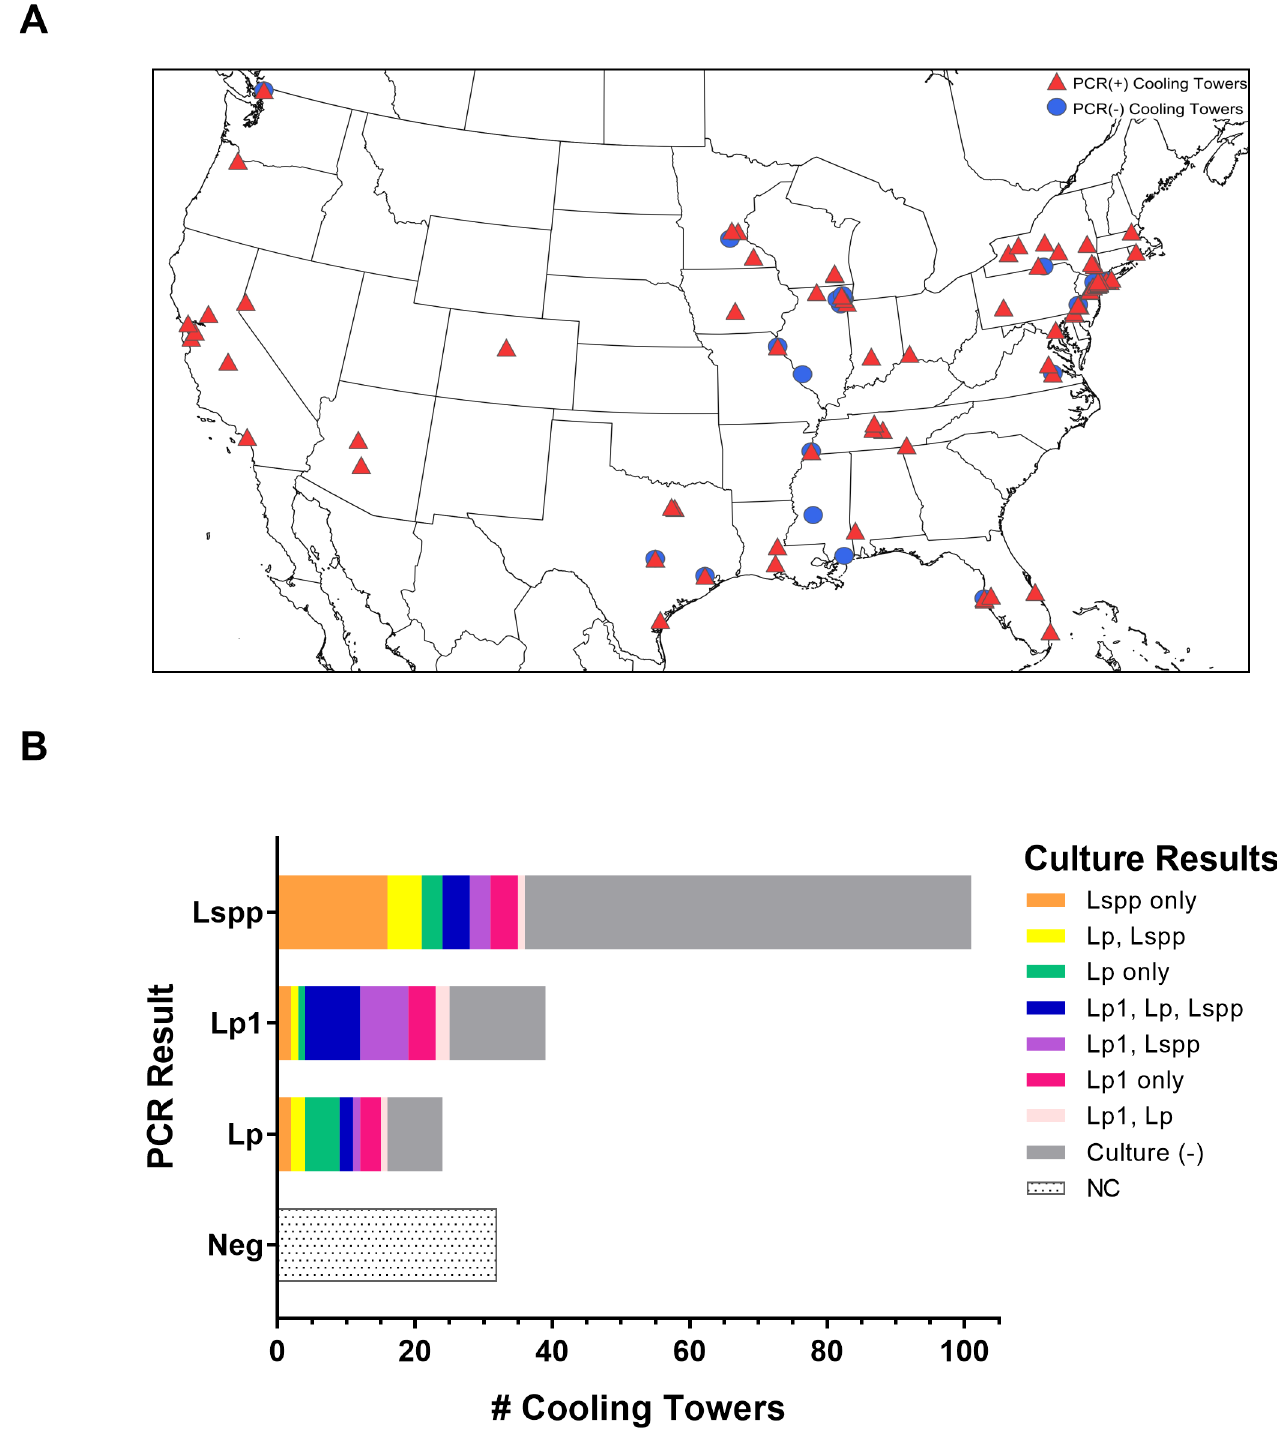
Fig 1. Cooling tower locations and PCR and culture results overview. The CT samplesin this study were from geographiclocationsacross the US (A). The approximate longitudeand latitudeof the city for each CT location is plotted on the map which was generatedwith SimpleMappr (www.simplemappr.net). CTs that were positive for Legionella DNA by PCR are representedby red triangles[PCR (+)] and those negativeby PCR are shown as blue circles [PCR (-)] (A). PCR (+) refers to a positive result for any of the three discrete probesin the PCR assay (Lspp, Lp, Lp1) (A). Each sample was assayed by PCR (A, B) and PCR-positive samples underwent culture (B). Samplesthat yieldedno isolates were culture-negative [Culture (-)]. PCR-negative sampleswere not cultured(NC).